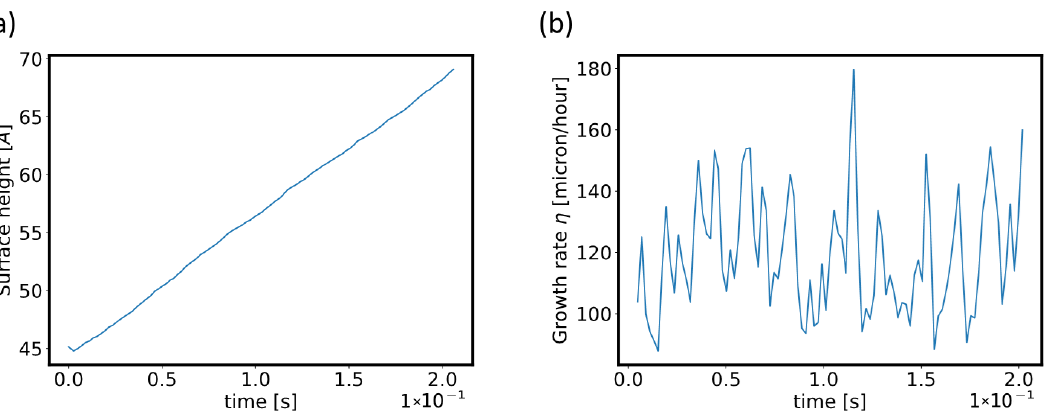
Figure 8. KMC MulSKIPS simulation with process conditions fixed to those of the experimental processed Sample A: ( a ) Time evolution of the surface average height; ( b ) growth rate variation.